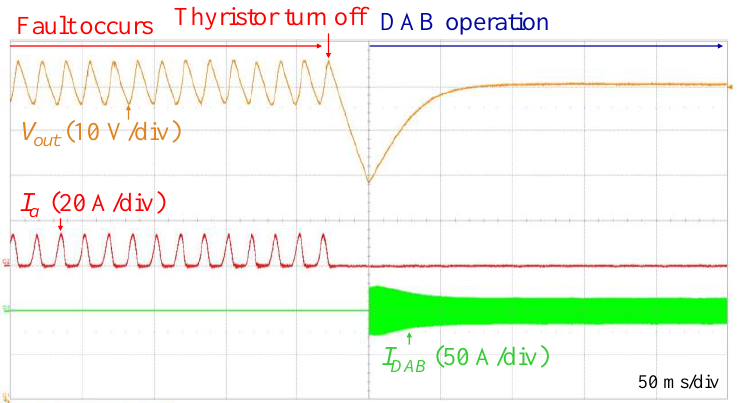
Figure 17. Output voltage regulation using the proposed protection algorithm and DAB converter.